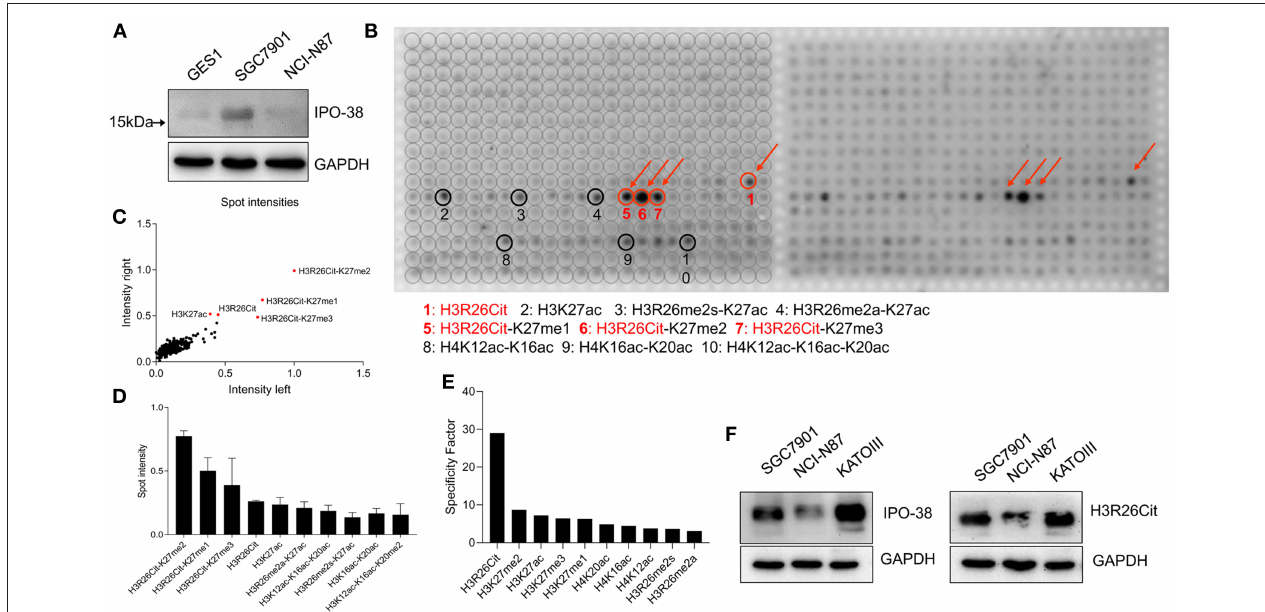
FIGURE 1 | Analysis of histone modification peptide array using IPO-38 monoclonal antibody. (A) The protein expression of IPO-38 in gastric mucosal cell GES-1 and gastric cancer cell lines. (B) Presentation of signal intensity on modified histone peptide array based on incubation with the IPO-38 monoclonal antibody. (C) The consistency assay of two repeated detections on the modified histone peptide array. (D) The top 10 histone modifications with the strongest binding to the IPO-38 monoclonal antibody. (E) The top 10 histone modification sites with the best specificity for IPO-38 monoclonal antibody binding. (F) Comparison of H3R26Cit and IPO-38 protein levels in three gastric cancer cell lines.